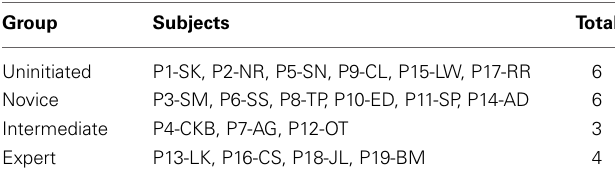
Table 1 | Allocation of subjects to groups according to level of